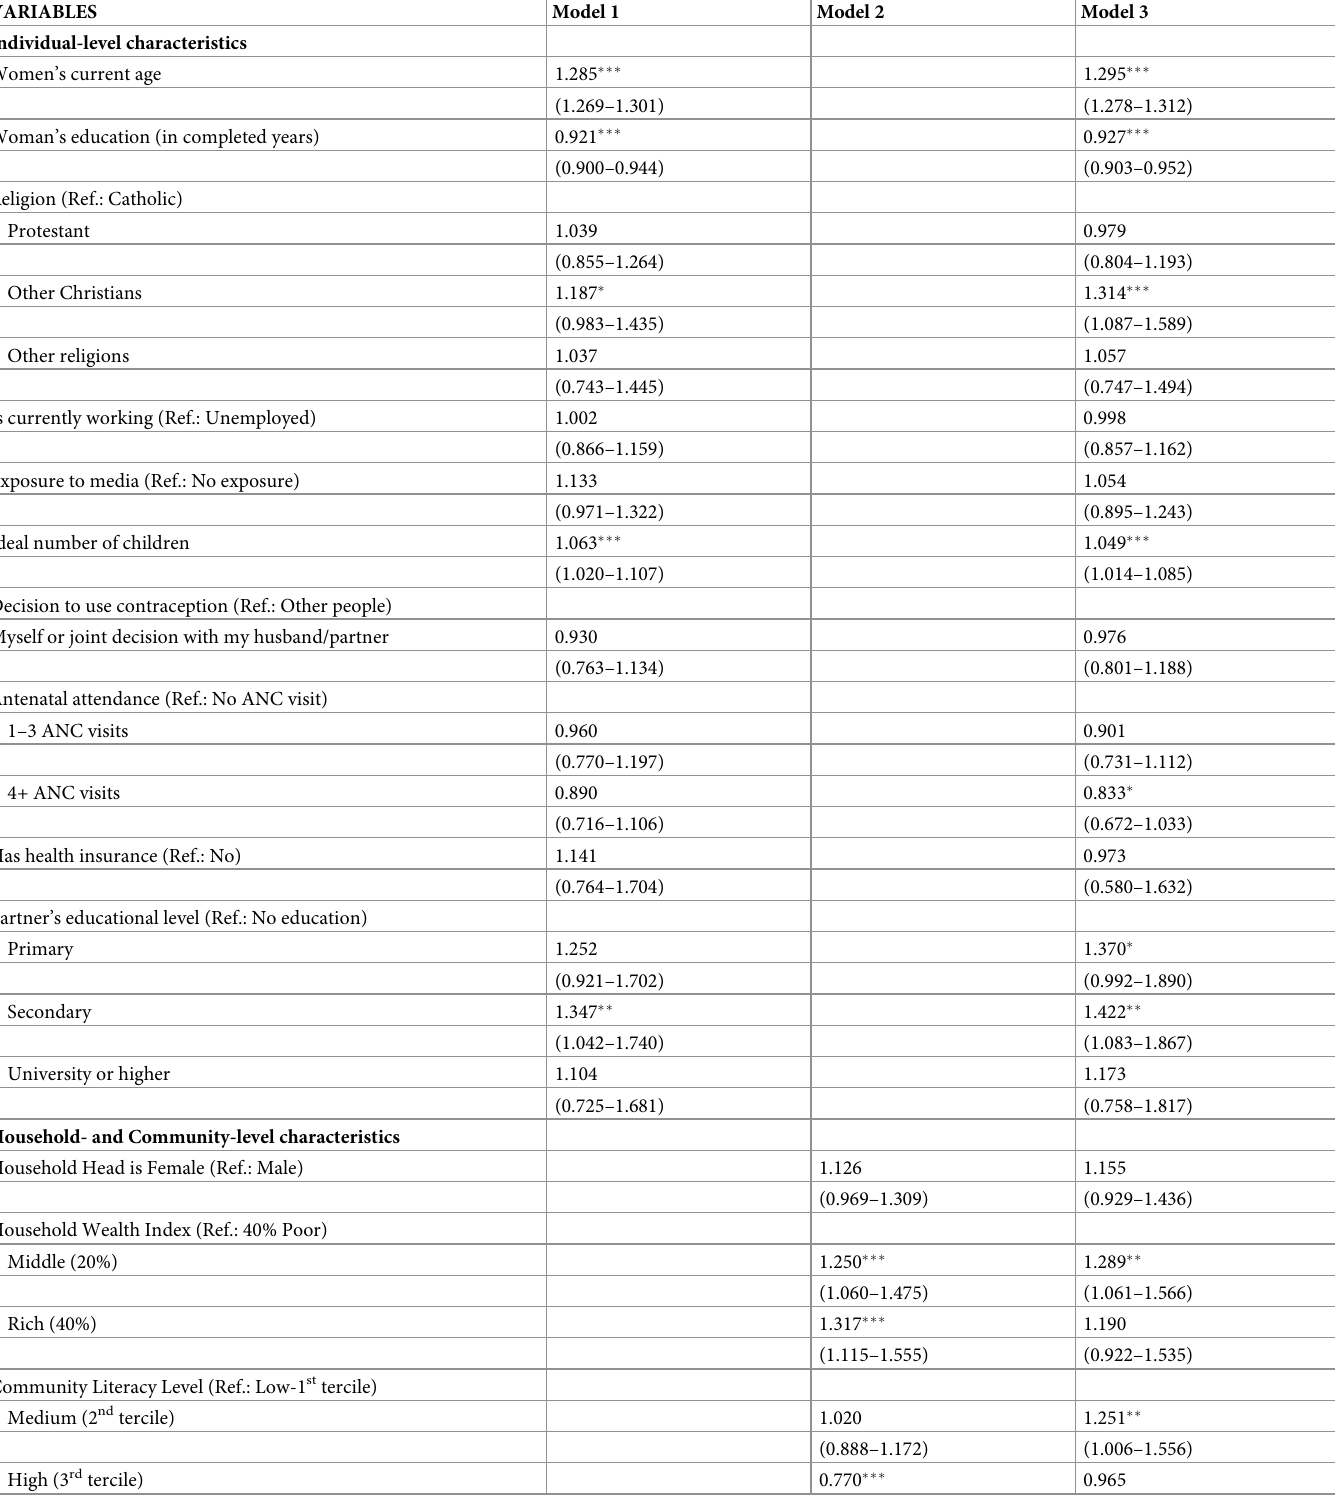
Table 2. Adjusted Odd Ratio (AOR) of experiencing high-risk fertility behaviours among married women in the Democratic Republic of the